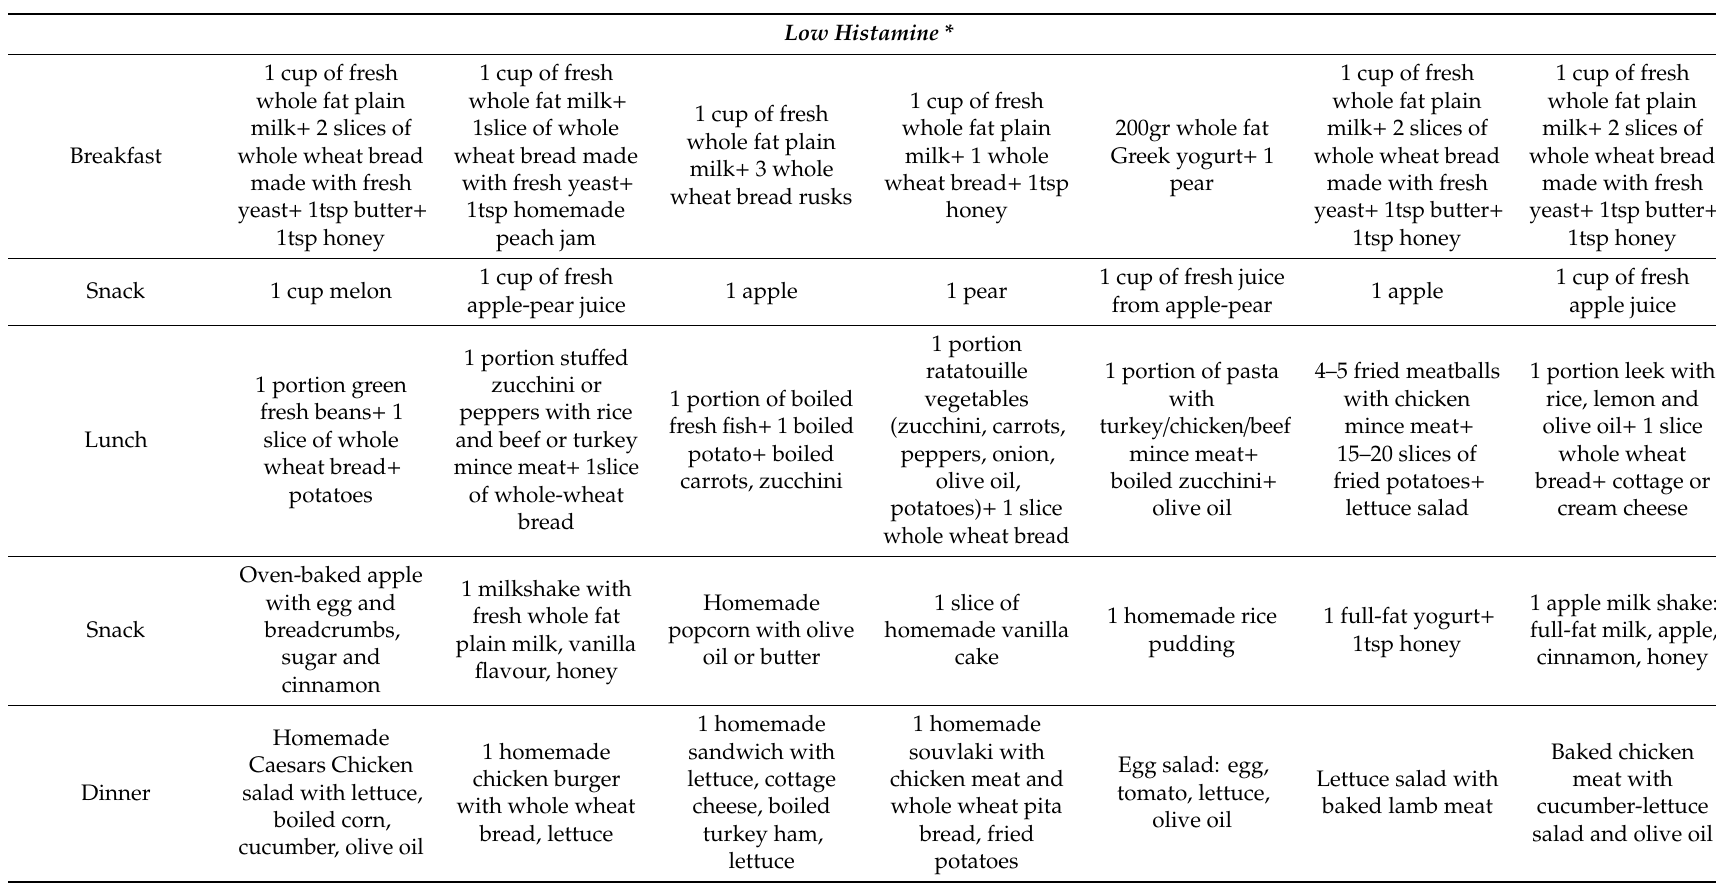
Table 2. Model weekly diet plan provided to the patients for the low-histamine (LH) and high-histamine (HH) period of the dietary intervention. Low Histamine